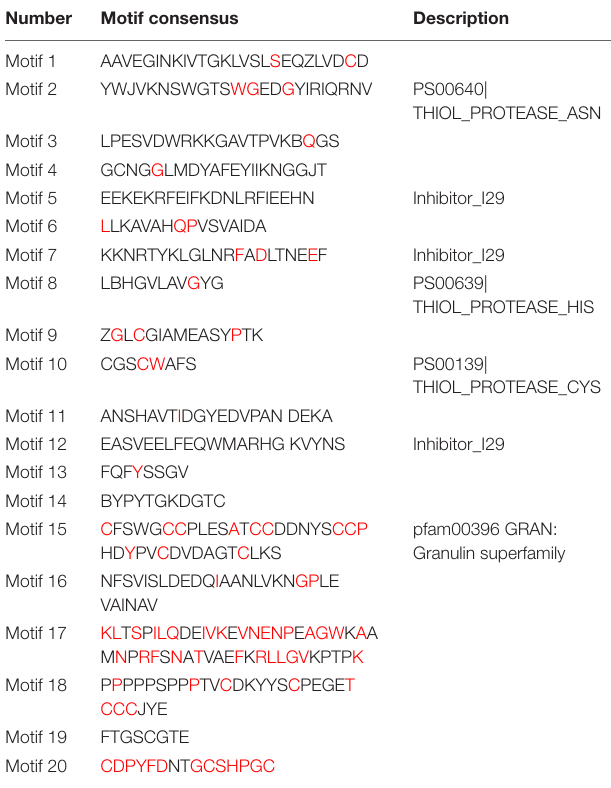
TABLE 2 | Putative motifs of fig PLCPs identified by MEME